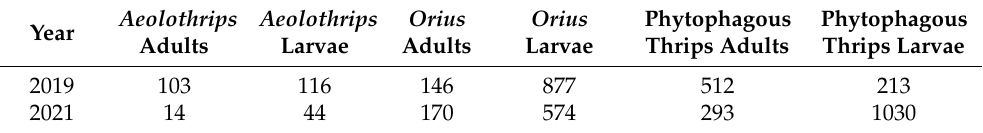
Table 1. Total insect numbers in chili flowers during growing seasons.